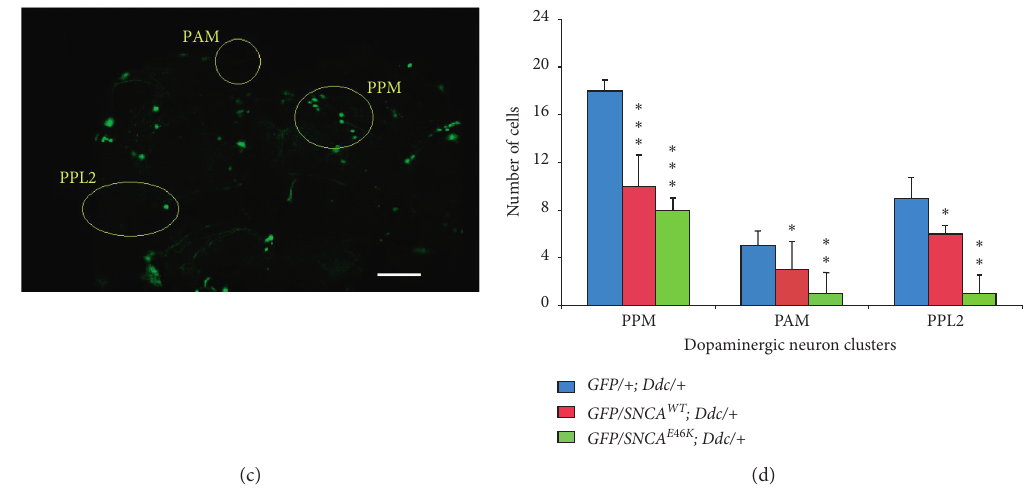
Figure 4: Confocal images of the brain of E46K α -synuclein transgenic flies demonstrate degeneration in protocerebral antero-medial (PAM), protocerebral postero-medial (PPM), and protocerebral postero-lateral (PPL) clusters of dopaminergic neurons. (a) GFP/+; Ddc/+ , (b) GFP/SNCA WT ; Ddc/+ , and (c) GFP/SNCA E46K ; Ddc/+. Scale bar, 50 μ m. (d) Cell counting indicates a significant reduction in the number of dopaminergic neurons up on SNCA E46K overexpression, which was prominent for the PPM cluster ( ∗ p < 0 . 05 , ∗∗ p < 0 . 01 , ∗∗∗ p < 0 . 001; by t -test; n � 15).